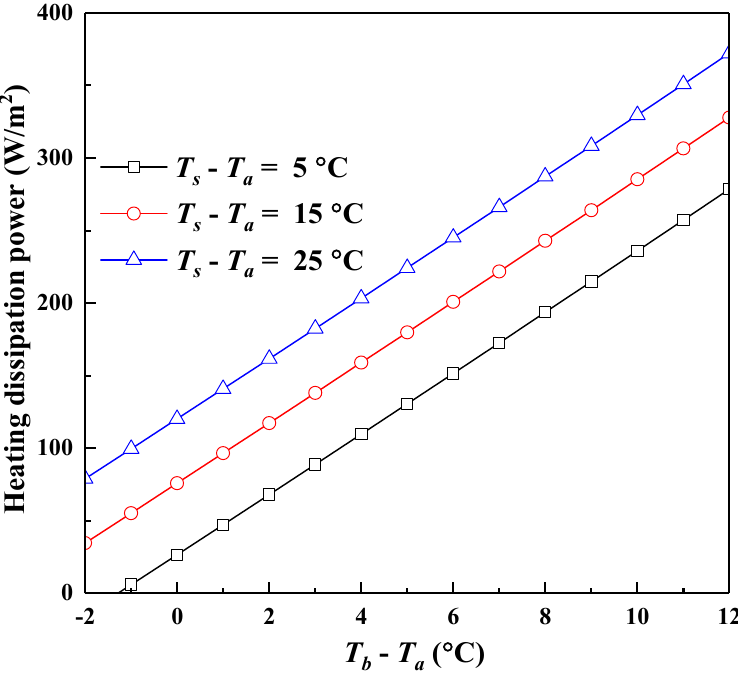
Figure 8. The variation of the heat dissipation power with temperature difference between the radiative plate surface and the ambient surroundings.